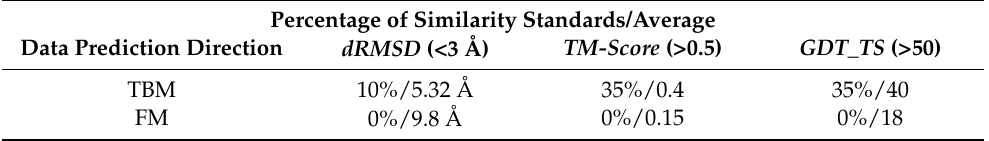
Table 2. Prediction accuracy of RGN.